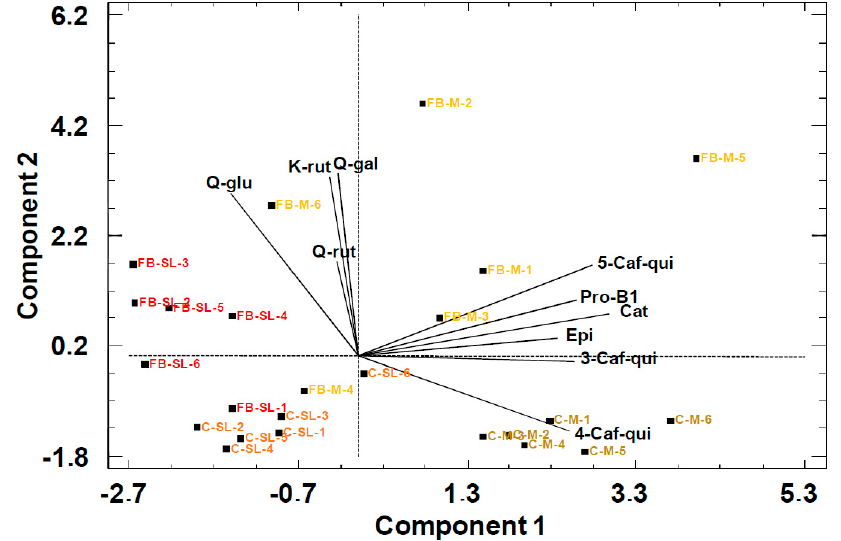
Figure 3. PCA bi-plot of peach purees with phenolic compounds as statistical variables. FB: Freshly blended, C: Commercial, SL: Spring Lady cultivar, and M: Miraflores cultivar. Ending number is the batch number. PC1: 42%, PC2: 32%.